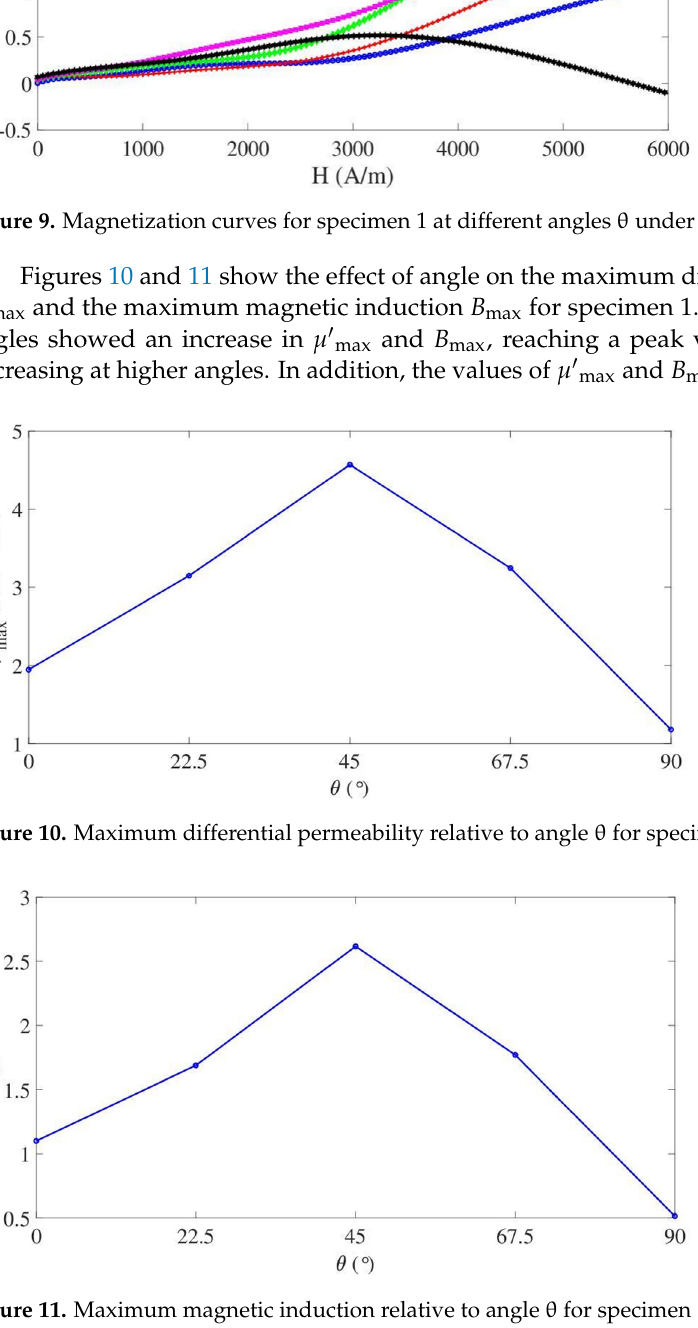
Figure 9. Magnetization curves for specimen 1 at different angles θ under a stress of 80 MPa .